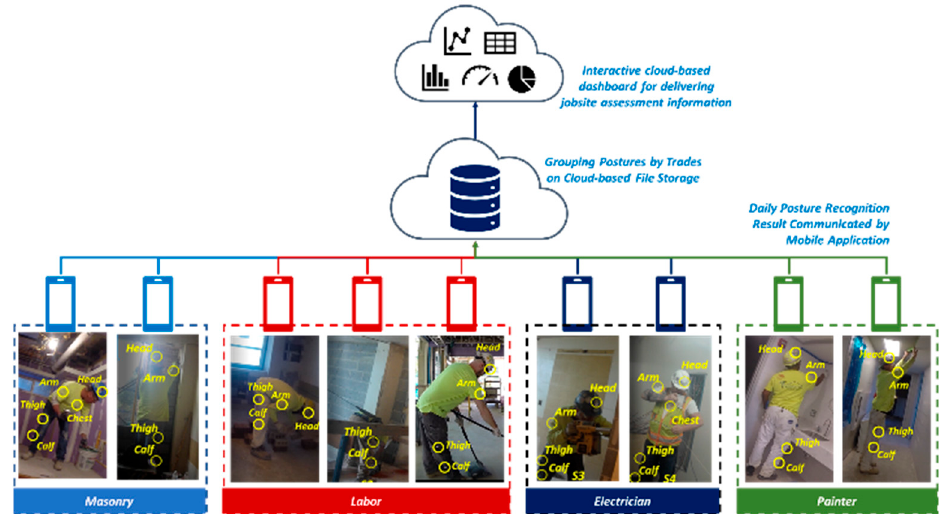
Figure 7. System architecture of the MSD assessment information delivery system.